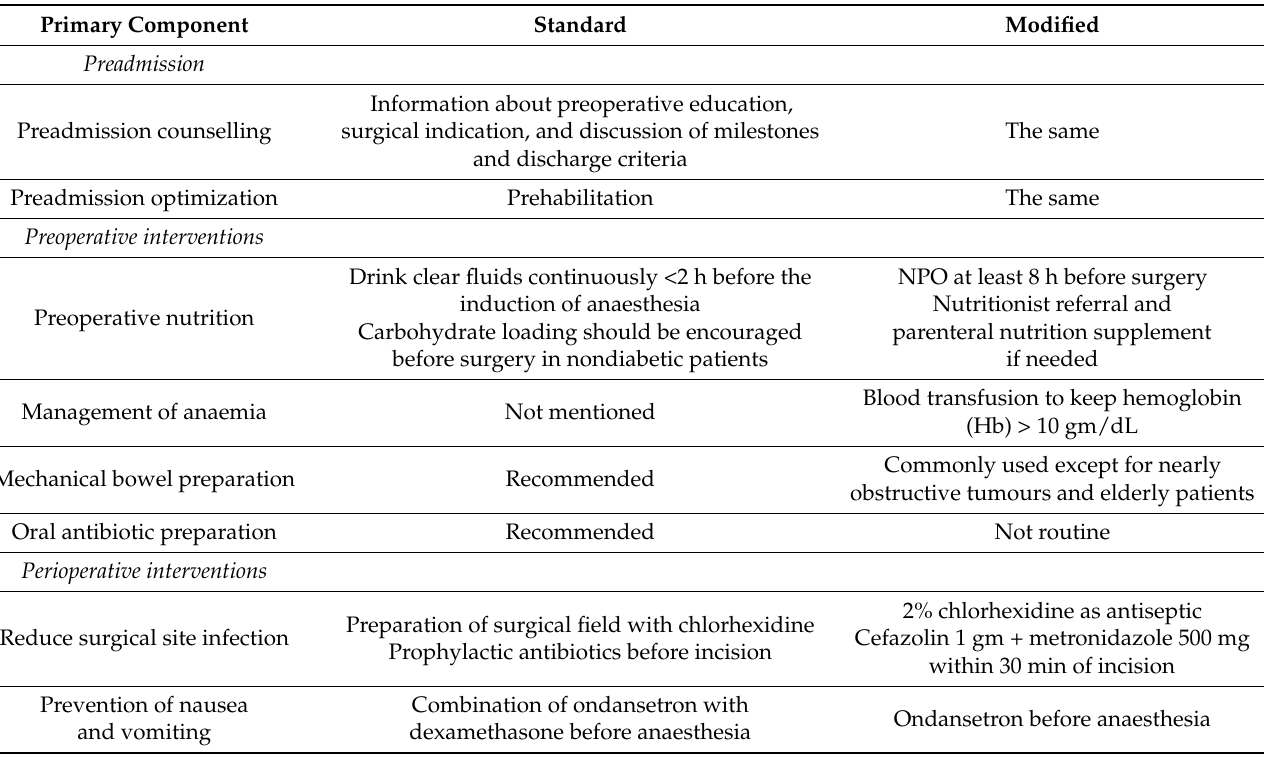
Table 1. Comparison of perioperative care protocol between standard and modified ERAS